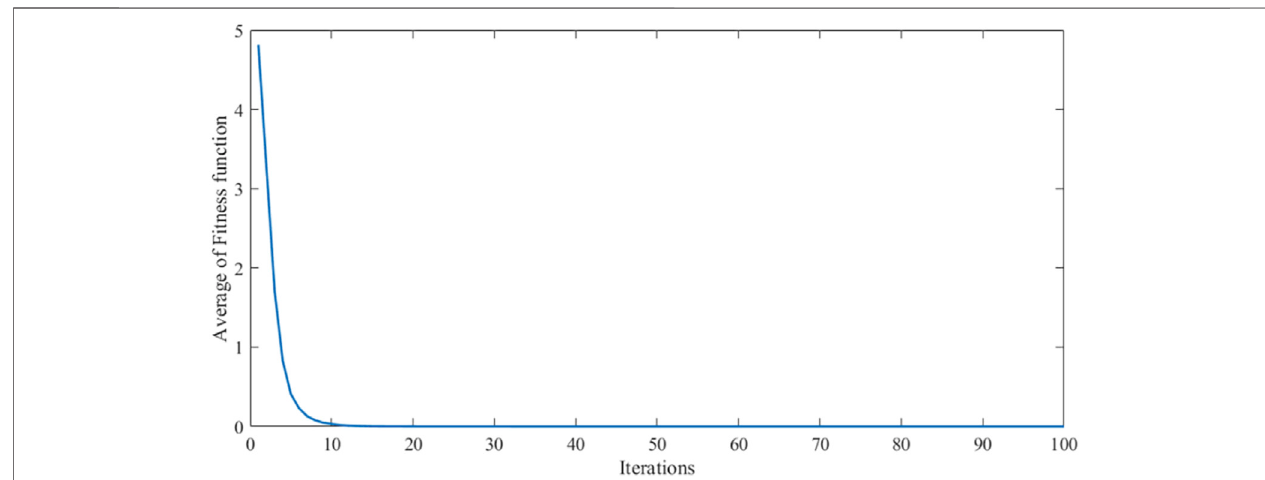
FIGURE 12 | Convergence curve of the algorithm along the